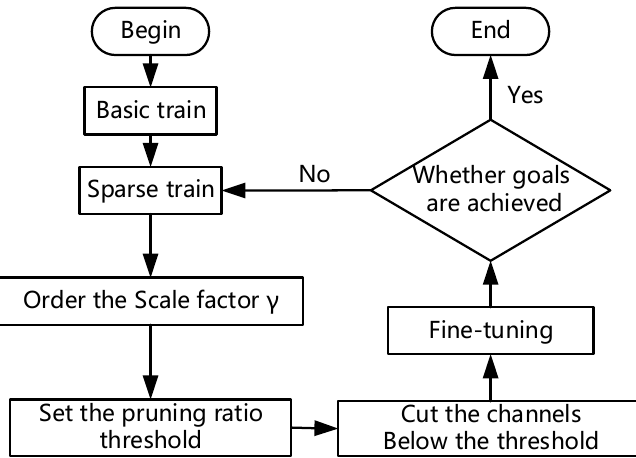
Figure 8. Flow diagram of model pruning.